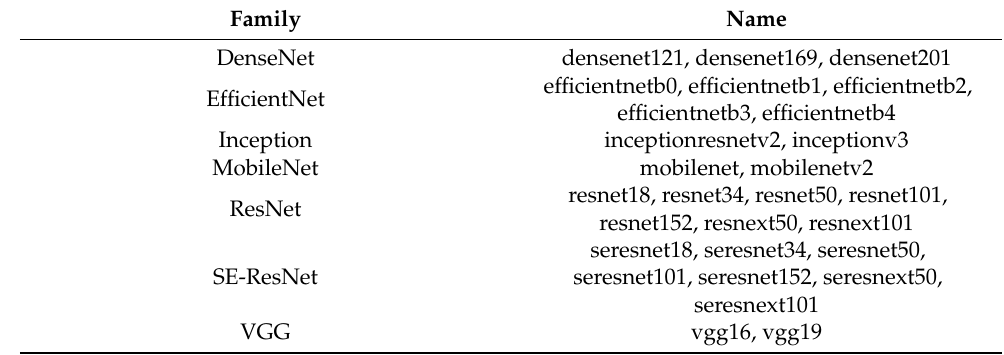
Table 1. Families and names of backbones.